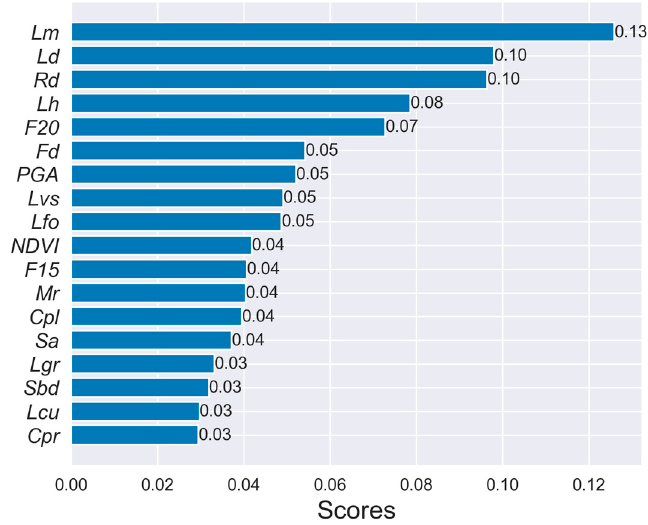
Figure 6. Importance ranking of factors.